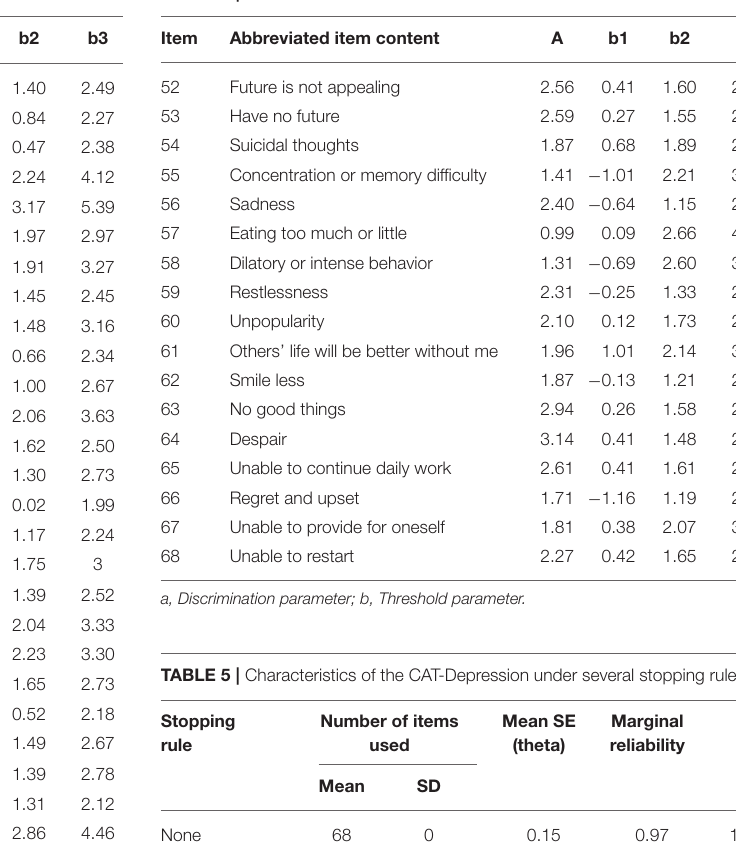
TABLE 4 | Item parameters of the final item bank with GRM.